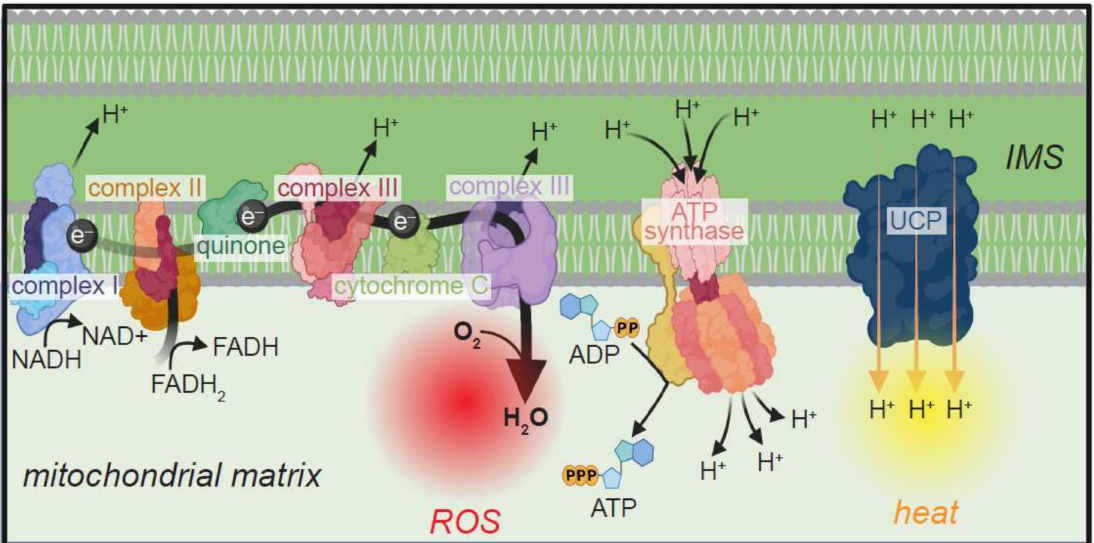
Figure 5. Uncoupling protein (UCP) mediated dissipation of the mitochondrial proton (H + ) gradient. ETC involves the transfers of electrons (e − ) from reducing equivalents (NADH and FADH 2 ) to molecular oxygen (O 2 ). e − transport is coupled with the movement of H + from the mitochondrial matrix to the intermembrane space (IMS). Subsequent dissipation of the electrochemical gradient through ATP synthase drives the production of ATP. Transfer of e − to O 2 also leads to the generation of superoxide ions and ROS. By mediating the transport of H + down their electrochemical gradient, UCPs dissipate the protonmotive force. Loss of protonmotive force results in the production of heat and prevents ATP production. Upon UCP-mediated H + leak, diminished transfer of e − to O 2 mitigates ROS production. Image created with BioRender.com (accessed 24 January